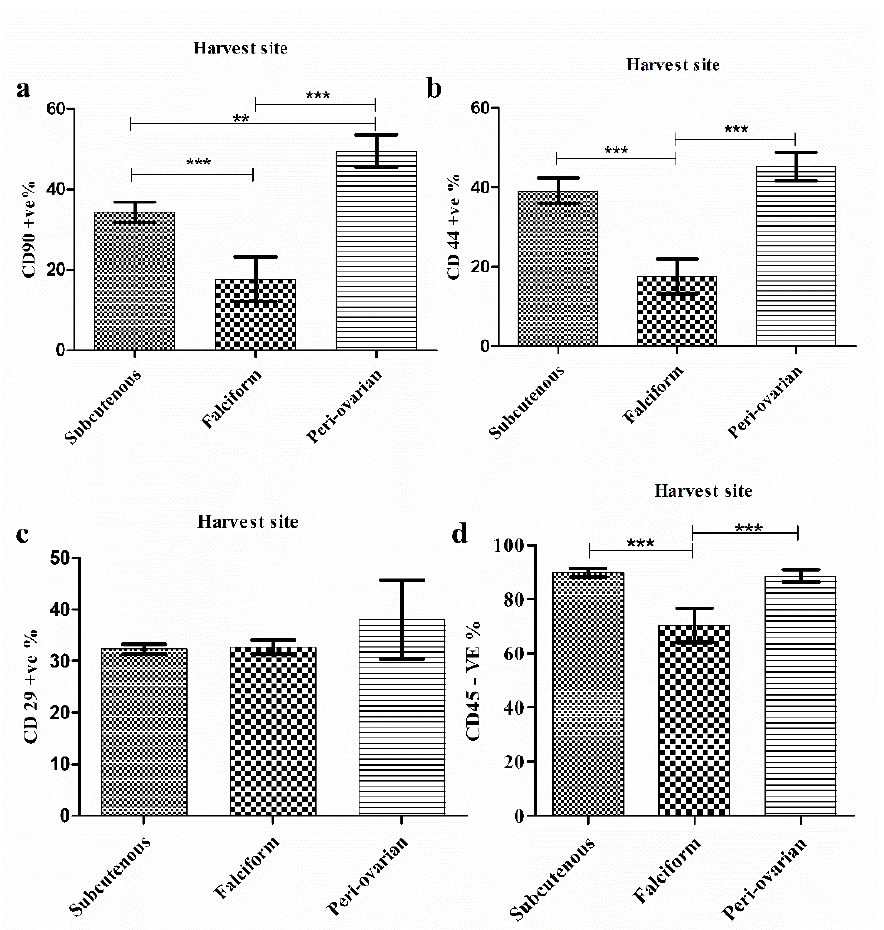
Figure 2. The effect of harvesting site on the mean percentage of adipose-derived mesenchymal stem cells surface marker expression in SVF cells. ( a ) The mean percentage of CD90 positive cells from different harvesting sites; ( b ) The mean percentage of CD44 positive cells from different harvesting sites; ( c ) The mean percentage of CD29 positive cells from different harvesting sites; ( d ) The mean percentage of CD45 negative cells from different harvesting sites. Data are represented as the mean percentage ± standard deviation ( n = 10). ** p < 0.01: a significant difference; *** p < 0.001: a highly significant difference.